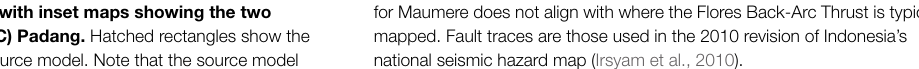
FIGURE 3 | Regional setting (A) with inset maps showing the two study areas (B) Maumere, and (C) Padang. Hatched rectangles show the area of the fault rupture for each source model. Note that the source model